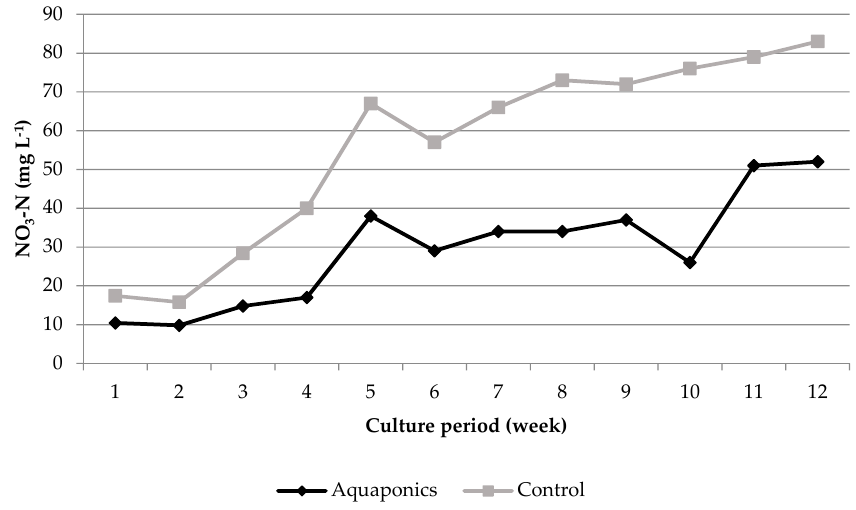
Figure 5. Temporal changes of nitrate (NO 3 -N) over the experimental period of 12 weeks.